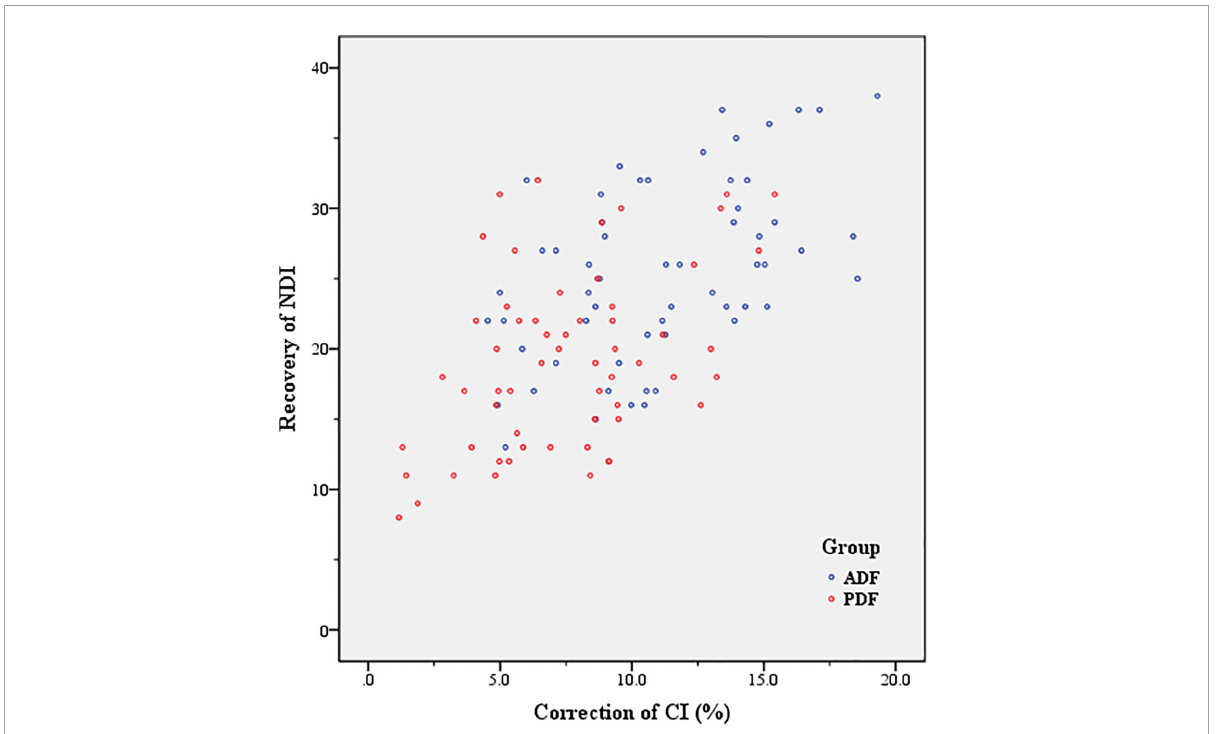
FIGURE6 Correlation between correction of curvature index (CI) and recovery of Neck Disability Index (NDI) (Axial symptom severity) in Group anterior decompression with fusion (ADF) ( r = 0.51, P < 0.001), and in Group posterior decompression with fixation (PDF) ( r = 0.45, P < 0.001).